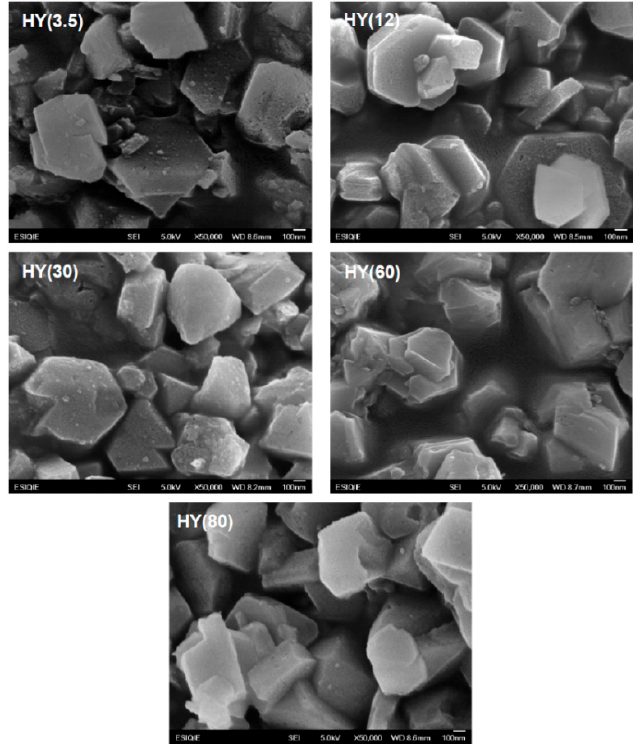
Figure A1. SEM micrographs of the fresh HY zeolites.